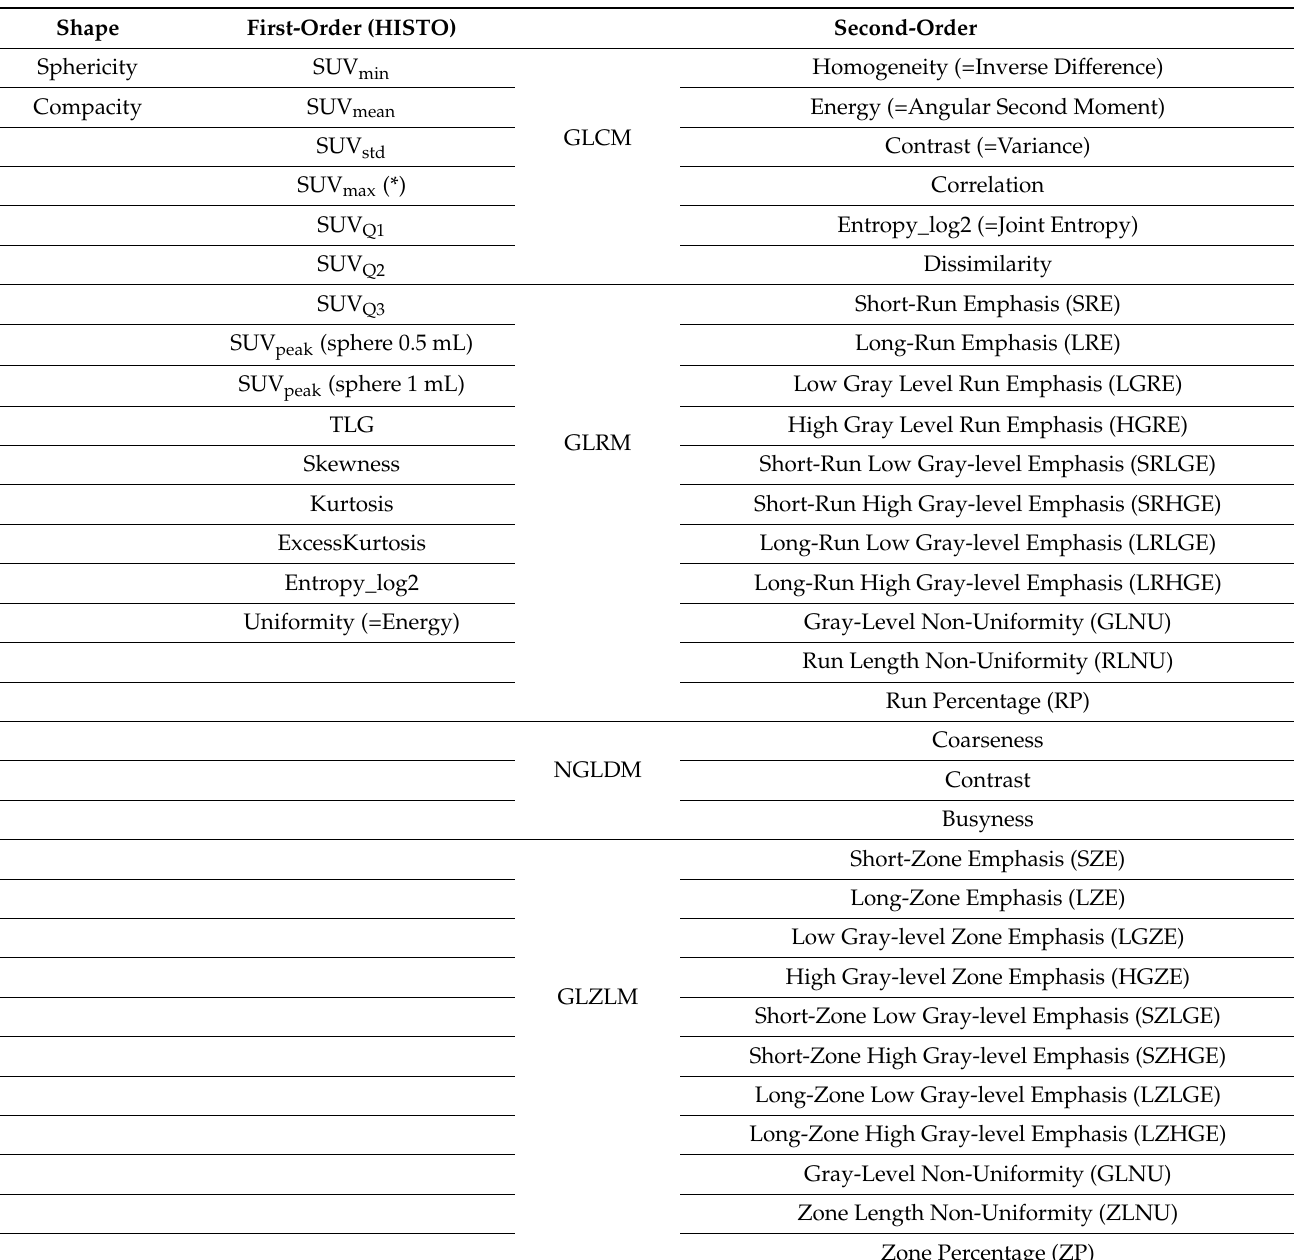
Table 1. Overview of the RFs analysed in the study. Mathematical definitions are available at: